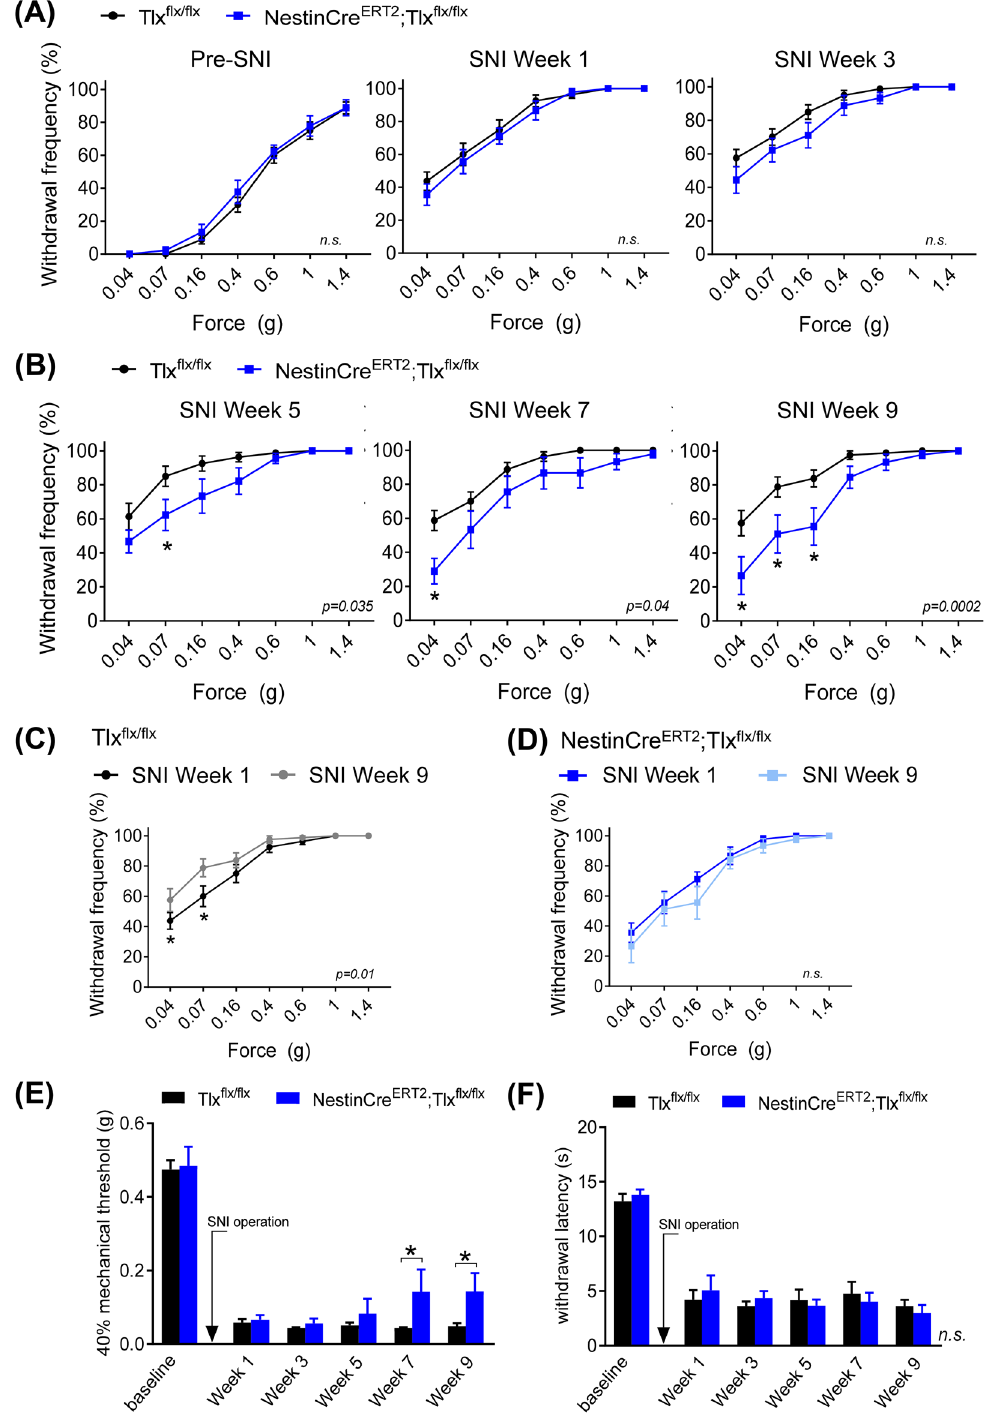
Figure 3. ( A,B ) Withdrawal frequency of hind paw to applications of graded von Frey forces pre-injury and 1, 3, 5, 7 and 9 weeks after sciatic nerve injury (SNI) in control TIx flx/flx and NestinCre ERT2 ;TIx flx/flx mice ( n = 16 and 9, respectively). ( C,D ) Comparison of paw withdrawal frequency to von Frey forces at early (week 1) versus late (week 9) stages after SNI in control TIx flx/flx mice ( C ) and NestinCre ERT2 ;TIx flx/flx mice ( D ). ( E ) Mechanical threshold and ( F ) withdrawal latency to cold (2 °C) recorded pre-injury and at 1, 3, 5, 7 and 9 weeks after SNI operation in control TIx flx/flx and NestinCre ERT2 ;TIx flx/flx mice. p values in figure panels indicate significance between entire curves. * p < 0.05, two-way ANOVA ( A,B ) with repeated measures ( C–F ); n.s. not